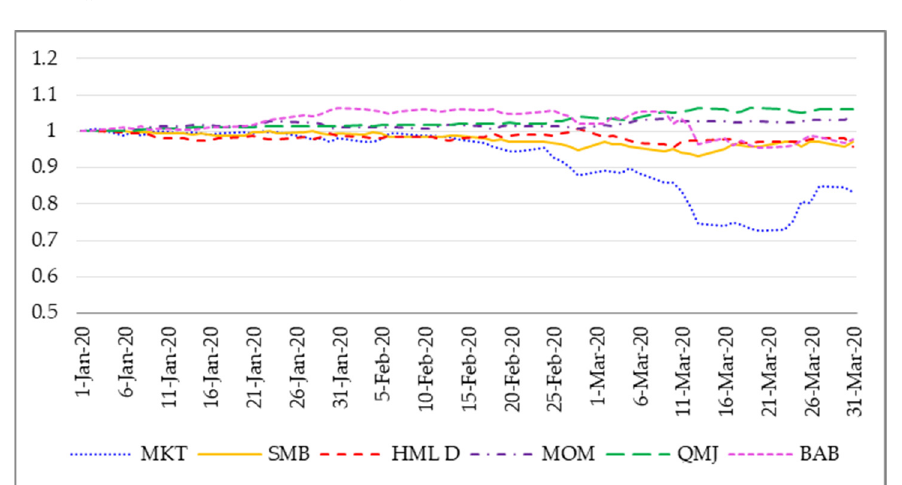
Figure 6. Cumulative Returns: By Country. This figure displays the time series behavior of the cumulative return of the different risk factors along two subsample periods: The Great Recession ( a1 – a6 ) and the COVID-19 crisis ( b1 – b6 ). The factors refer to different stock markets around the world: The United States (1), Germany (2), Great Britain (3), Australia (4), Hong Kong (5), and Japan (6). See notes in Table 1 for the definition of the factors.